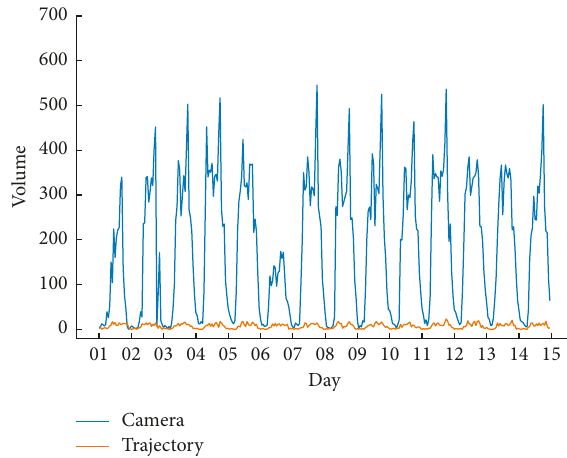
Figure 2: Volume comparison between camera and trajectory